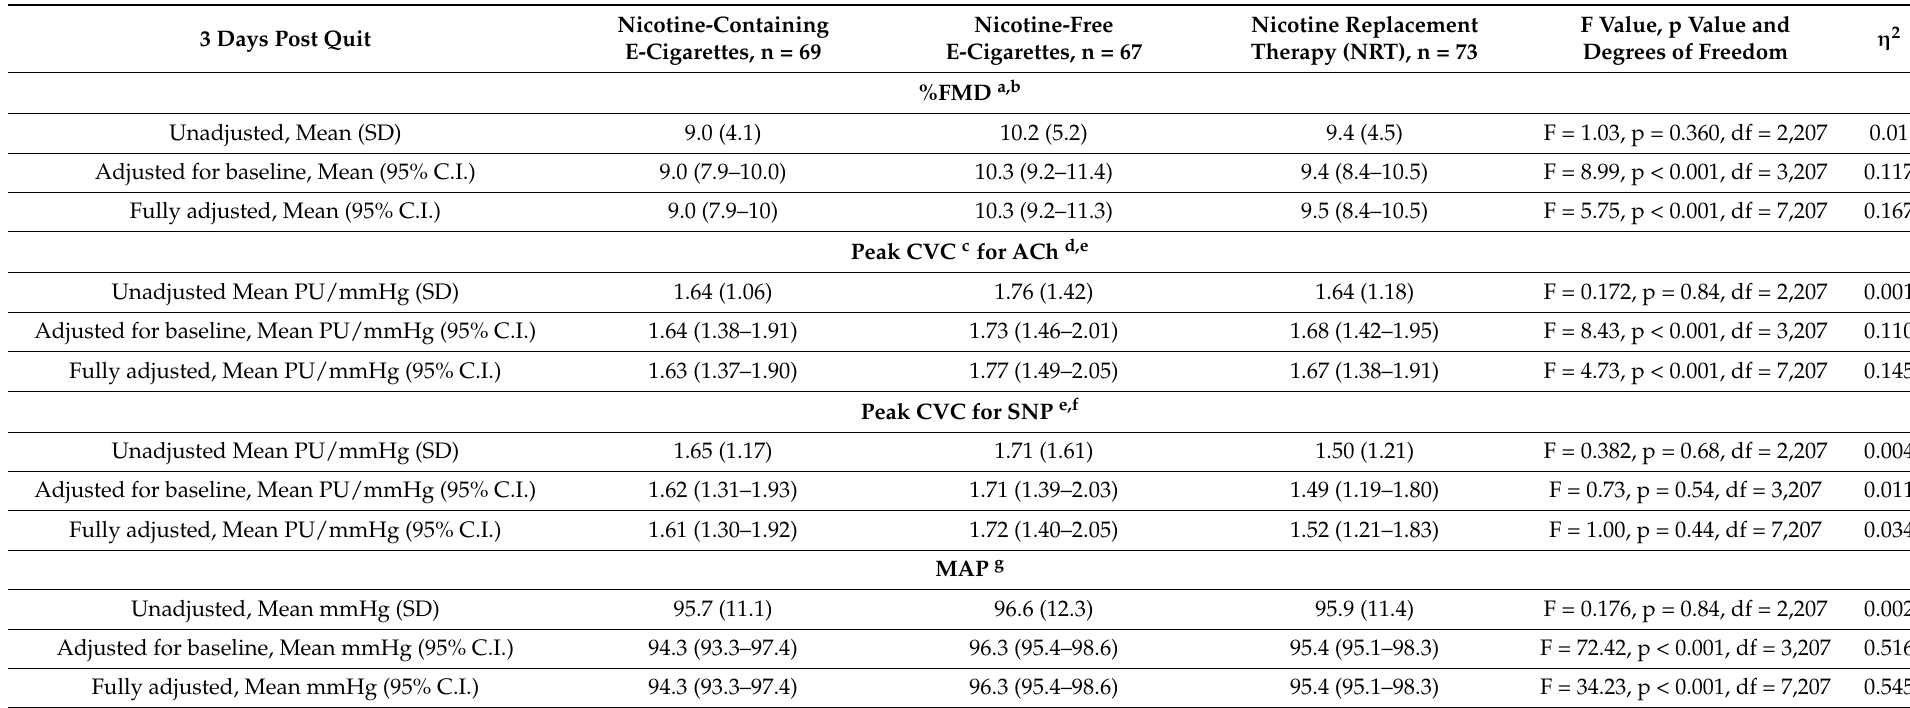
Table 2. Presentation of the results for the General Linear Model for all outcomes at 3 days post quit in all